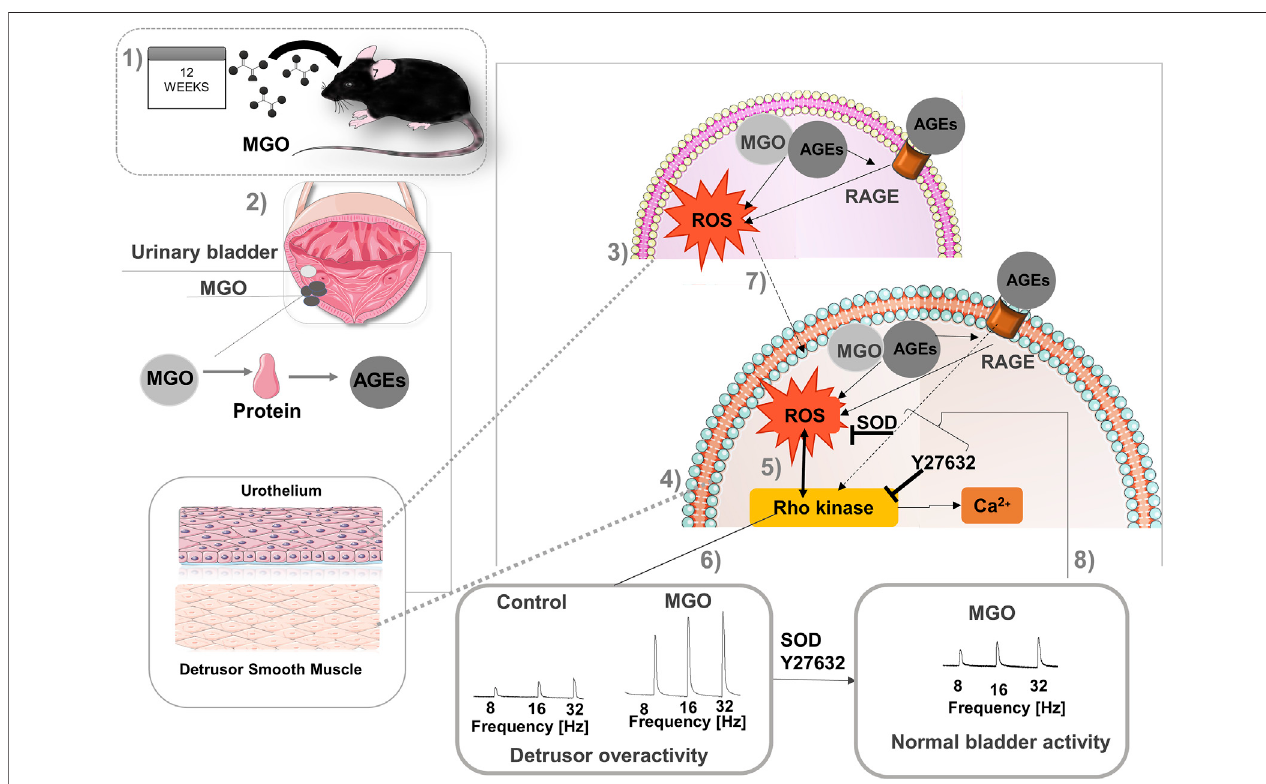
FIGURE8 | Proposal ofmechanisms involved in detrusor overactivity induced prolonged intake of methylglyoxal (MGO) in female mice. Methylglyoxal wasgiven at 0.5% in the drinking water of female mice for 12 weeks (1). In urinary bladder (2), MGO generates advanced glycation end products (AGEs) that interacts with its cell surfacereceptor,RAGE,inbothurothelium(3)anddetrusorsmoothmuscle(4),leadingtoexcessofreactive-oxygenspecies(ROS)generationinbothlayers.Indetrusor smooth muscle cells, ROS activates the Rho kinase system (5), ultimately leading to Ca 2+ sensitization and detrusor overactivity (6). Alternatively, RAGE activation may directly activate Rho kinase further elevating the ROS levels. ROS produced in urothelium (7) may also diffuse to detrusor cells amplifying the smooth muscle contraction. Bladder incubation with superoxide dismutase (SOD) or the Rho kinase inhibitor Y27632 signi fi cantly reduce the detrusor overactivity, normalizing the bladder activity (8). This image was produced with the assistance of Servier Medical Art (https://smart.servier.com) licensed by a Creative Commons Attribution 3.0 Unported